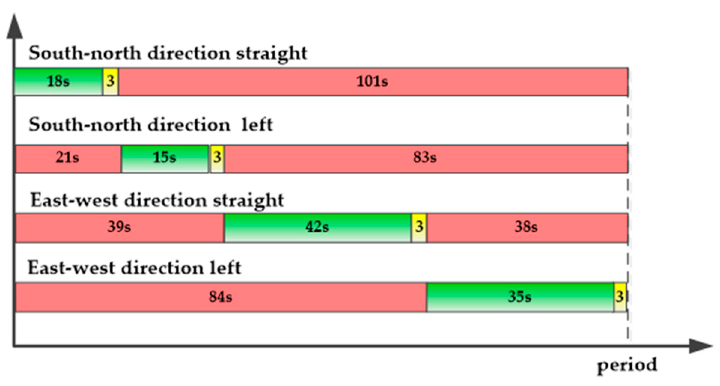
Figure 10. Southbound left-turn adjusted phase time.